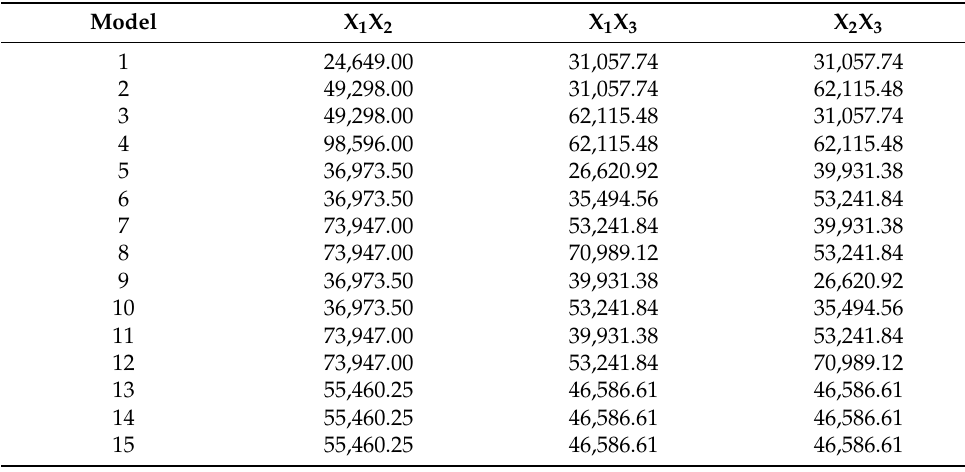
Table 8. Design Matrix-Interaction Terms.